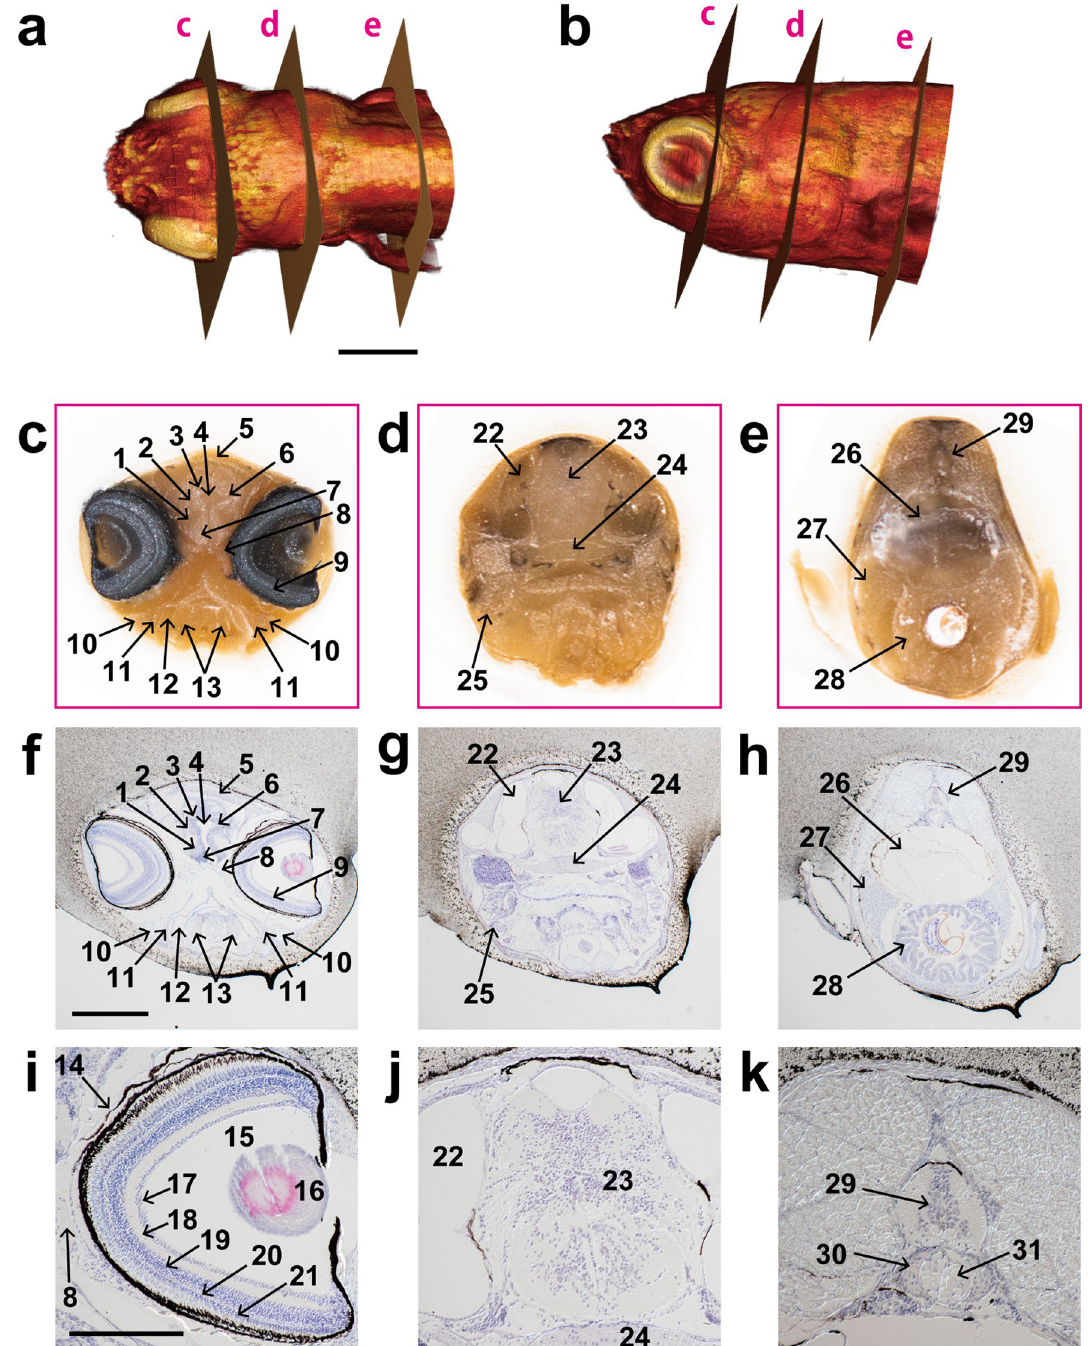
Figure 2. Correlation between 3D image and sections of juvenile zebrafish. A juvenile zebrafish (30 dpf) is sliced at a thickness of 5 µm using CoMBI-S. ( a , b ) 3D volume-rendered image using 568 block-face images. ( c – e ) Examples of block-face images. ( f – h ) Sections were collected at the positions corresponding to ( c – e ), and stained with hematoxylin and eosin. ( i – k ) Higher magnification of ( f – h ). 1: lateral forebrain bundle, 2: ventral thalamus, 3: dorsal thalamus, 4: telencephalic ventricle, 5: habenula, 6: zona limitans intrathalamica, 7: preoptic region, 8: optic nerve, 9: retina, 10: mandibular cartilage, 11: palatoquadrate ceratohyal, 12: